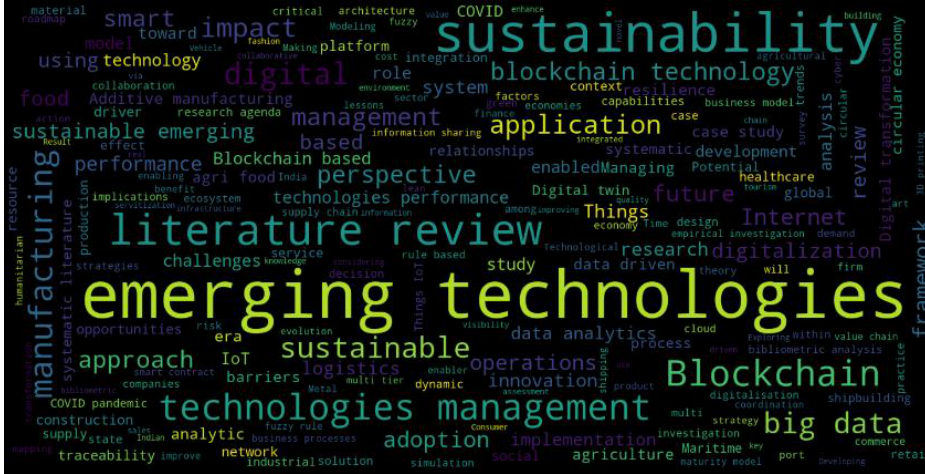
Figure 5. Word Cloud on “Title”.